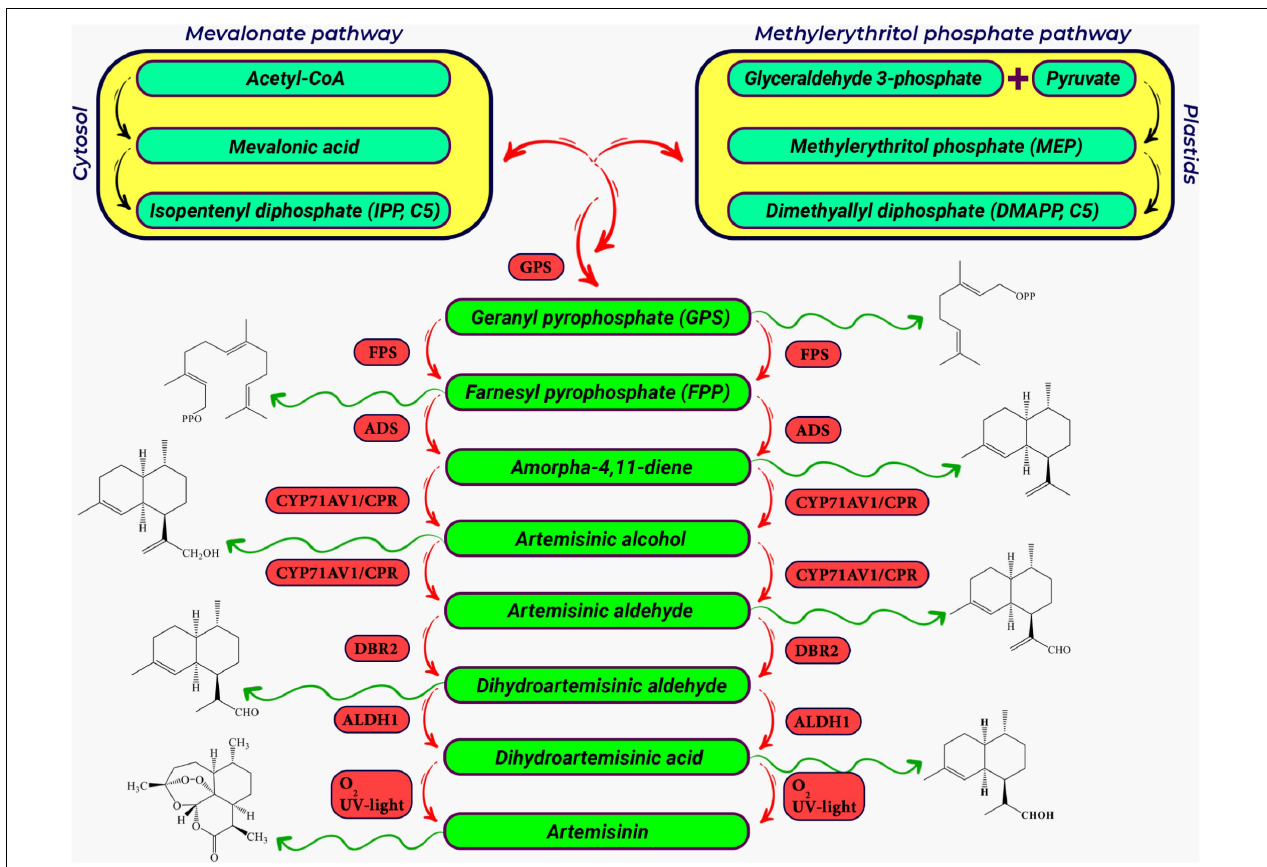
FIGURE 3 | A schematic representation of the artemisinin biosynthetic pathway in Artemisia annua L. The precursors for artemisinin biosynthesis (DMAPP and IPP) are produced in the cytosolic Mevalonate (MVA) pathway and the plastidal 2-C-Methylerythritol 4-phosphate pathway (MEP) pathway, respectively (Dewick, 2009; Vranová et al., 2013; Beyraghdar Kashkooli et al., 2019). IPP+DMAPP are converted to FPP, which is the general precursor for sesquiterpenes (Fuentes et al., 2016). In sequential enzymatic steps, FPP is converted to amorphadiene, artemisinin alcohol, artemisinic aldehyde, dihydroartemisinic aldehyde, and finally artemisinic